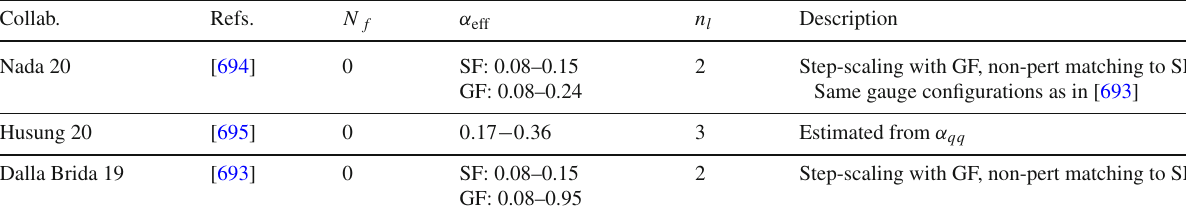
Table 170 Renormalization scale and perturbative behaviour of α s determinations for N f = 0 Collab.